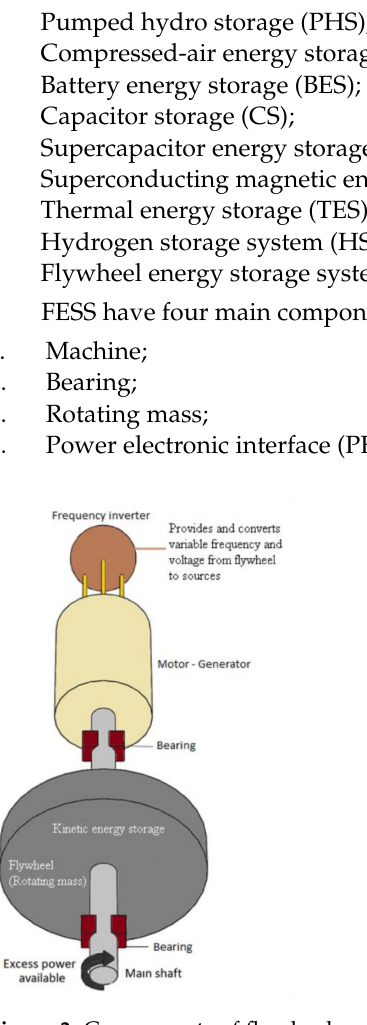
Figure 3. Components of flywheel energy storage system, reproduced with permission from Else- vier